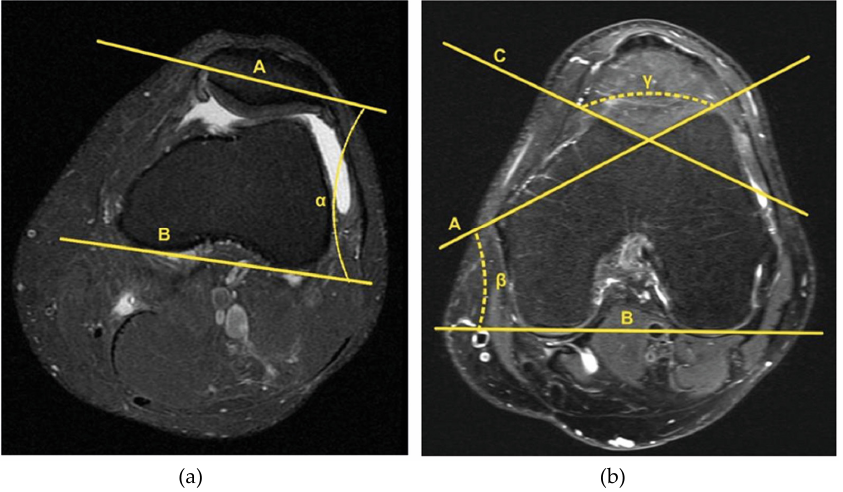
Figure 3. ( a ) Patella tilt angle (PTA) = α : angle between a straight line through the transverse axis of the patella (A) and a tangent along the posterior femoral condyles (B). ( b ) Lateral trochlear inclination angle (LTI) = β : angle between the tangent along the facies patellaris femoris lateralis (A) and the posterior condylar tangential line (B). Sulcus angle (SA) = γ : angle between the lateral facies patellaris femoris (A) and the medial facies patellaris femoris (C). Patellar tendon thickness (PTT) was measured in the sagittal plane on the MRI image with the greatest distance between the base patella and apex patella. Tendon thickness was measured proximally at the origin of the tendon (PTTprox), distally at the insertion at the tibial tuberosity (PTTdistal) and at the midpoint of these two points (PTTmid) (Fig- ure 4a). In the same image, the presence of signal intensity was also checked (Figure 4b). The patella–patellar tendon angle (PPTA) measures the angle between the line drawn from the base of the patella to the apex (A) and the line drawn between the apex of the patella to the insertion of the patellar tendon on the tibial tuberosity (B) (Figure 4c).